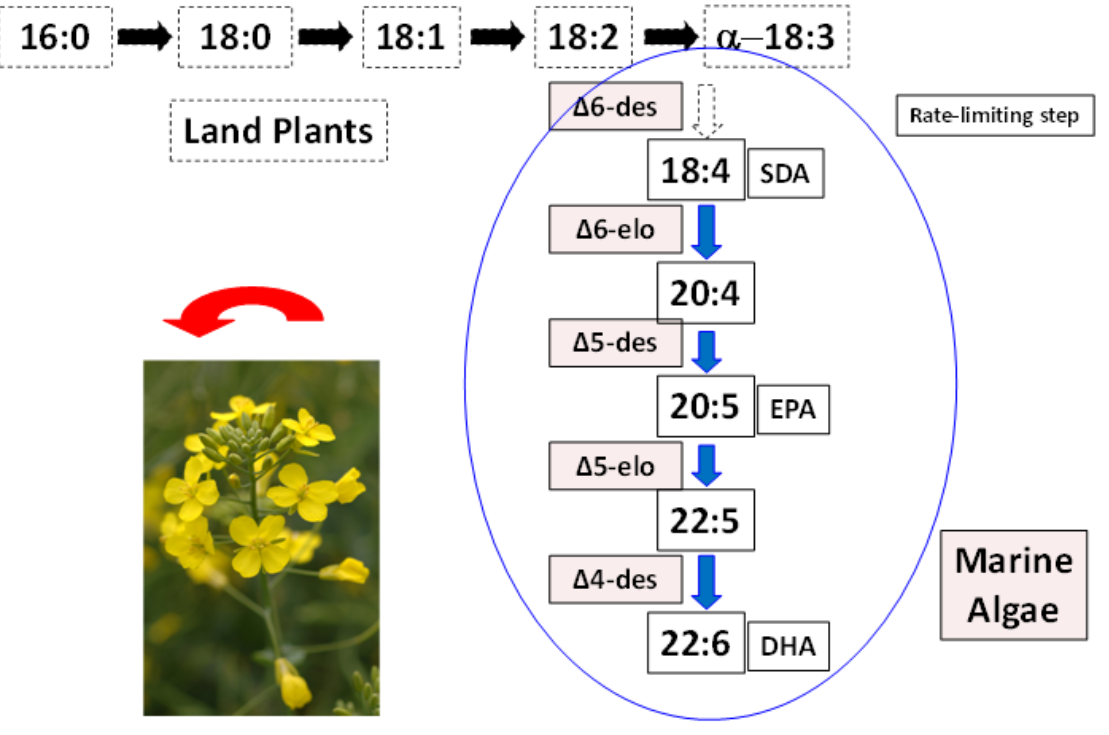
Figure 2 . Schematic showing synthesis of shorter-chain fatty acids in land plants ( black horizontal arrows ), followed by addition of genes from marine microalgae ( blue vertical arrows ) resulting in new LC omega-3 containing oilseeds. elo, elongase; des, desaturase.